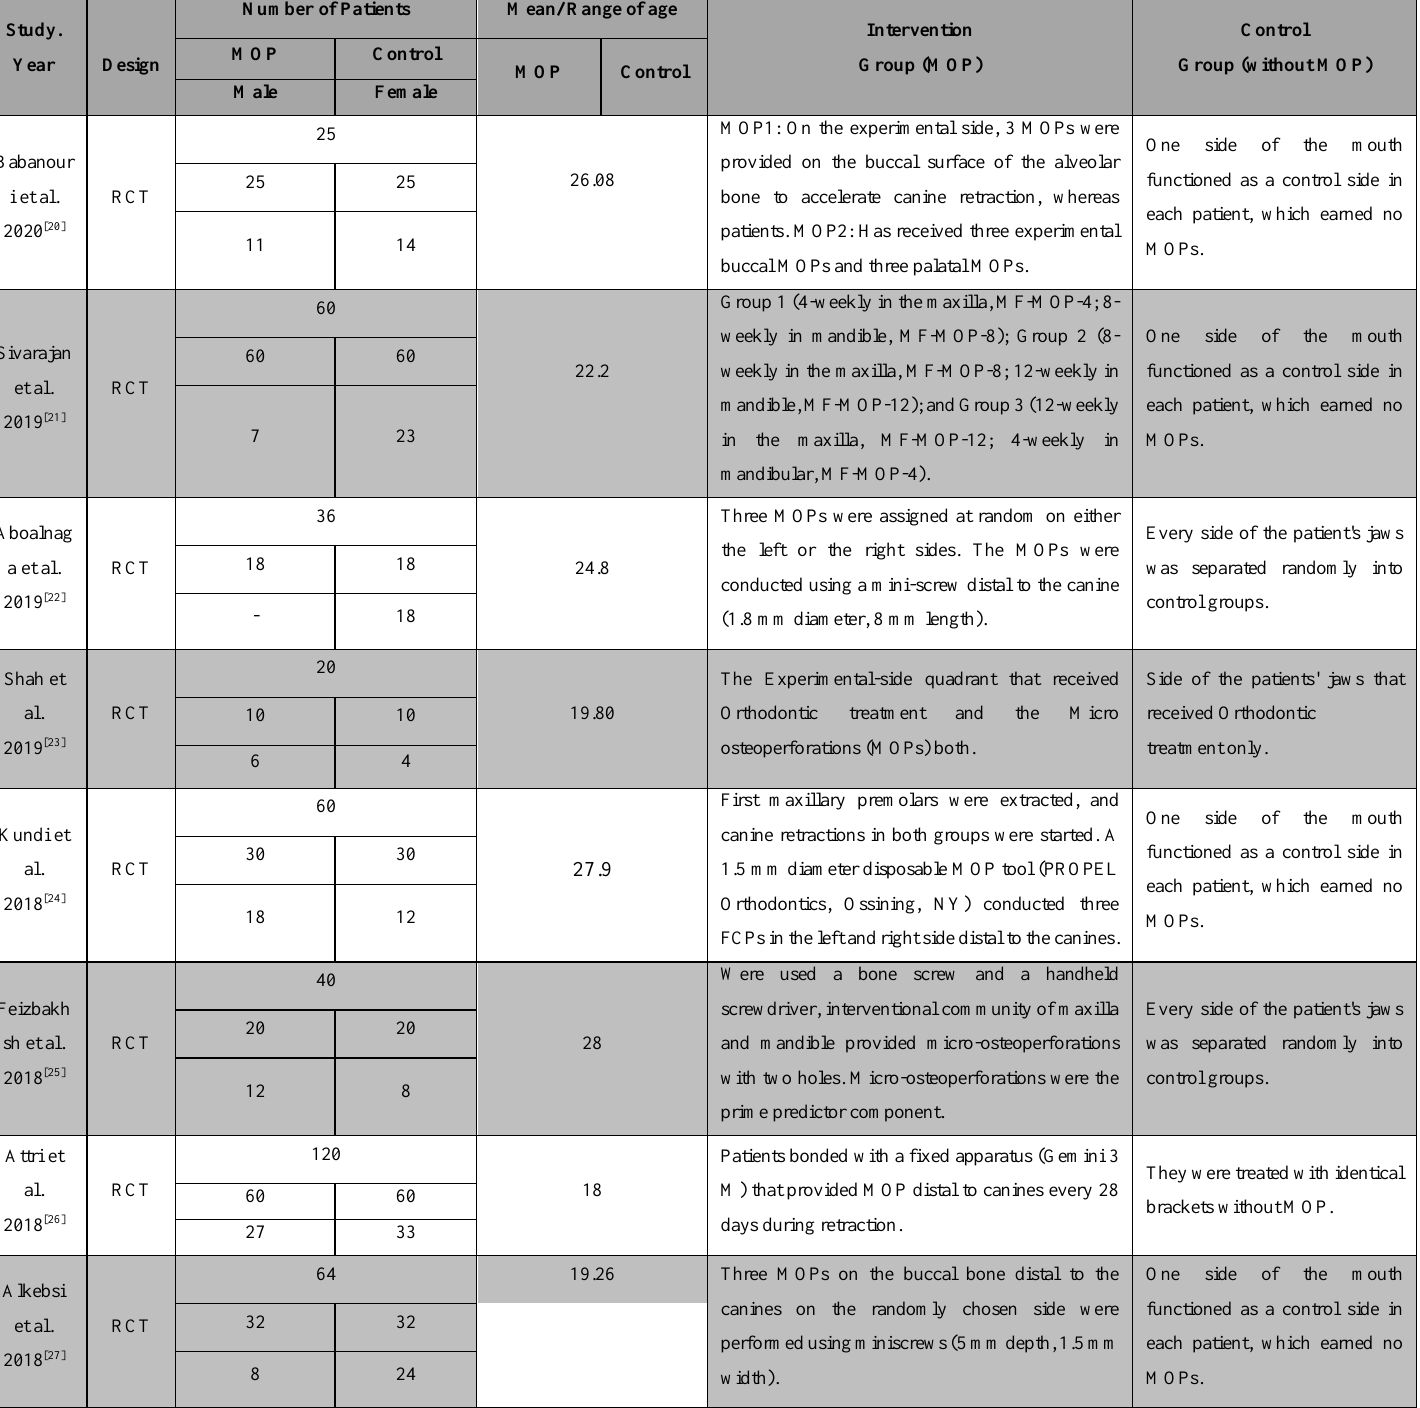
Table 2. Studies selected for systematic review and